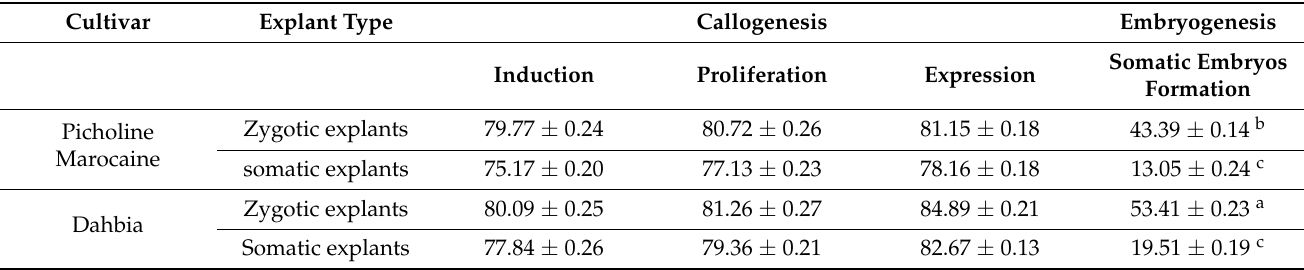
Table 1. Rates (%) of callogenesis and embryogenesis obtained for the zygotic (proximal cotyledons) and somatic (distal leaf fragments) explants of the olive cvs. Dahbia and Picholine Marocaine, on the induction (4 weeks for the zygotic explants and 6 weeks for the somatic explants), proliferation (4 weeks for both types of explants), and expression (4 weeks with refreshment for both types of explants) phases of the